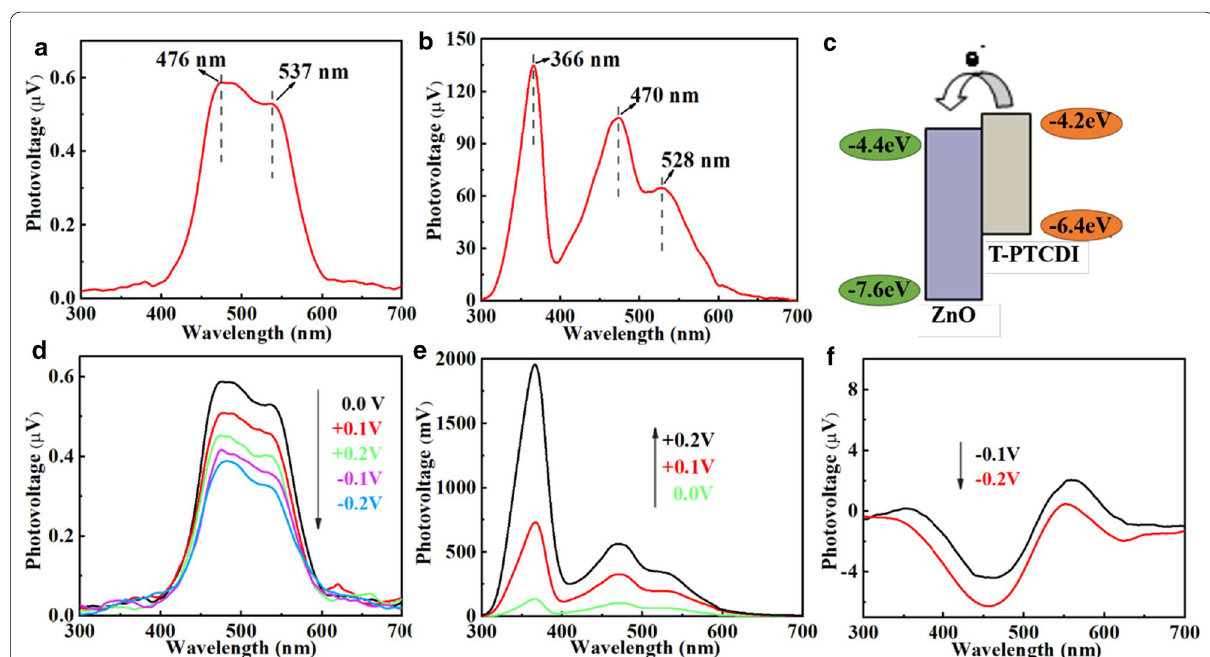
Fig. 4 SPS of a T-PTCDI and b T-PRCDI/ZnO nanorod composites, c energy-level alignment of ZnO and T-PTCDI. d FISPS of T-PTCDI and e , f T-PRCDI/ ZnO nanorod